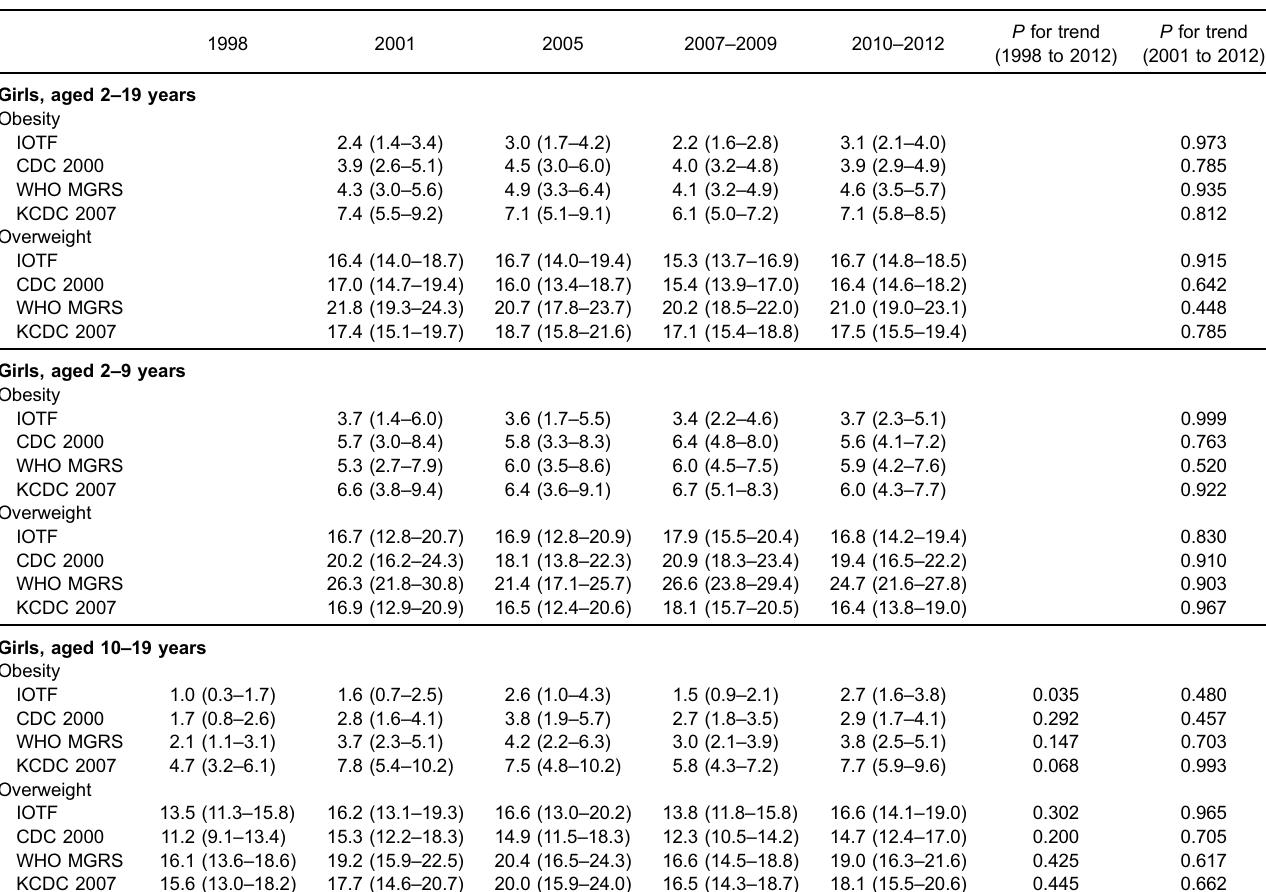
Table 4. Trends in age-standardized prevalence (95% con fi dence intervals) of overweight and obesity among South Korean